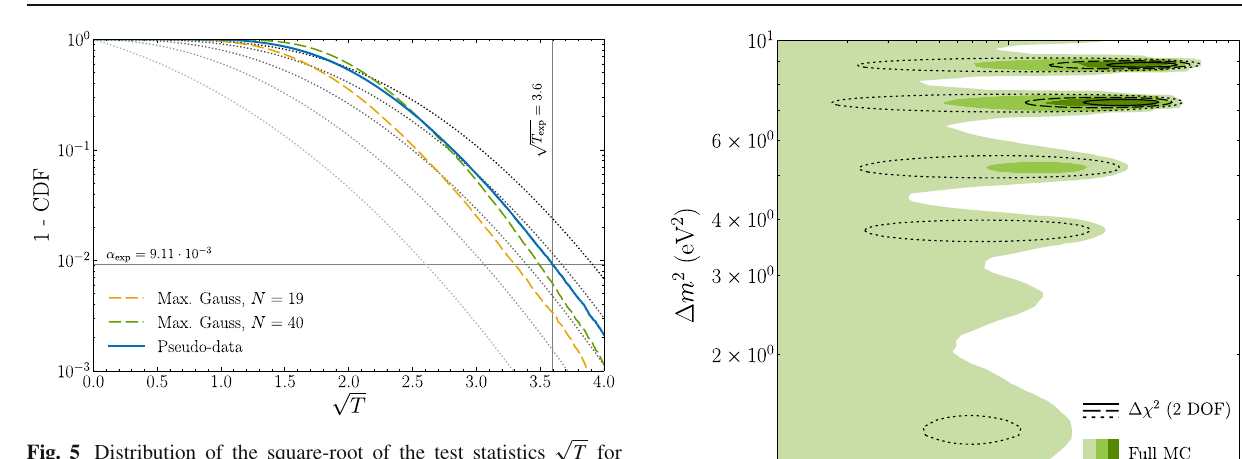
Fig. 5 Distribution of the square-root of the test statistics the Neutrino-4 experiment, obtained from the simulation of 100,000 pseudo-data sets under the assumption of no oscillations. The numer- ical result (solid blue curve) is compared to the expectation for a χ 2 distribution with 1 ... 5 DOF (dotted curves, from left to right), as well as to the distribution for the max. Gauss distribution with 19 and 40 bins (dashed curves). The vertical line indicates the value of obtainedfromtheobservedNeutrino-4data,whereasthehorizontalline shows the corresponding p -value